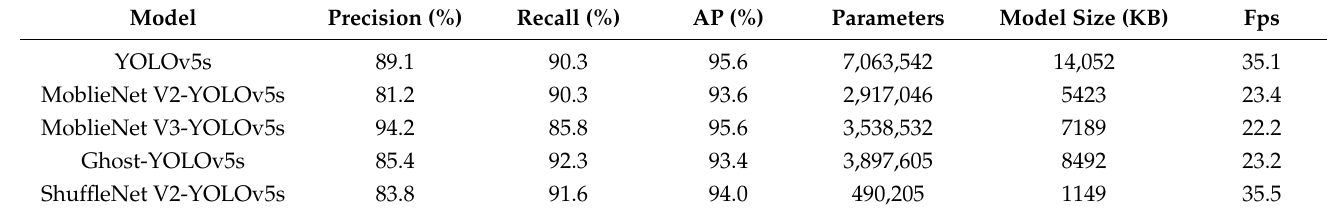
Table 4. The comparison of different backbone networks.